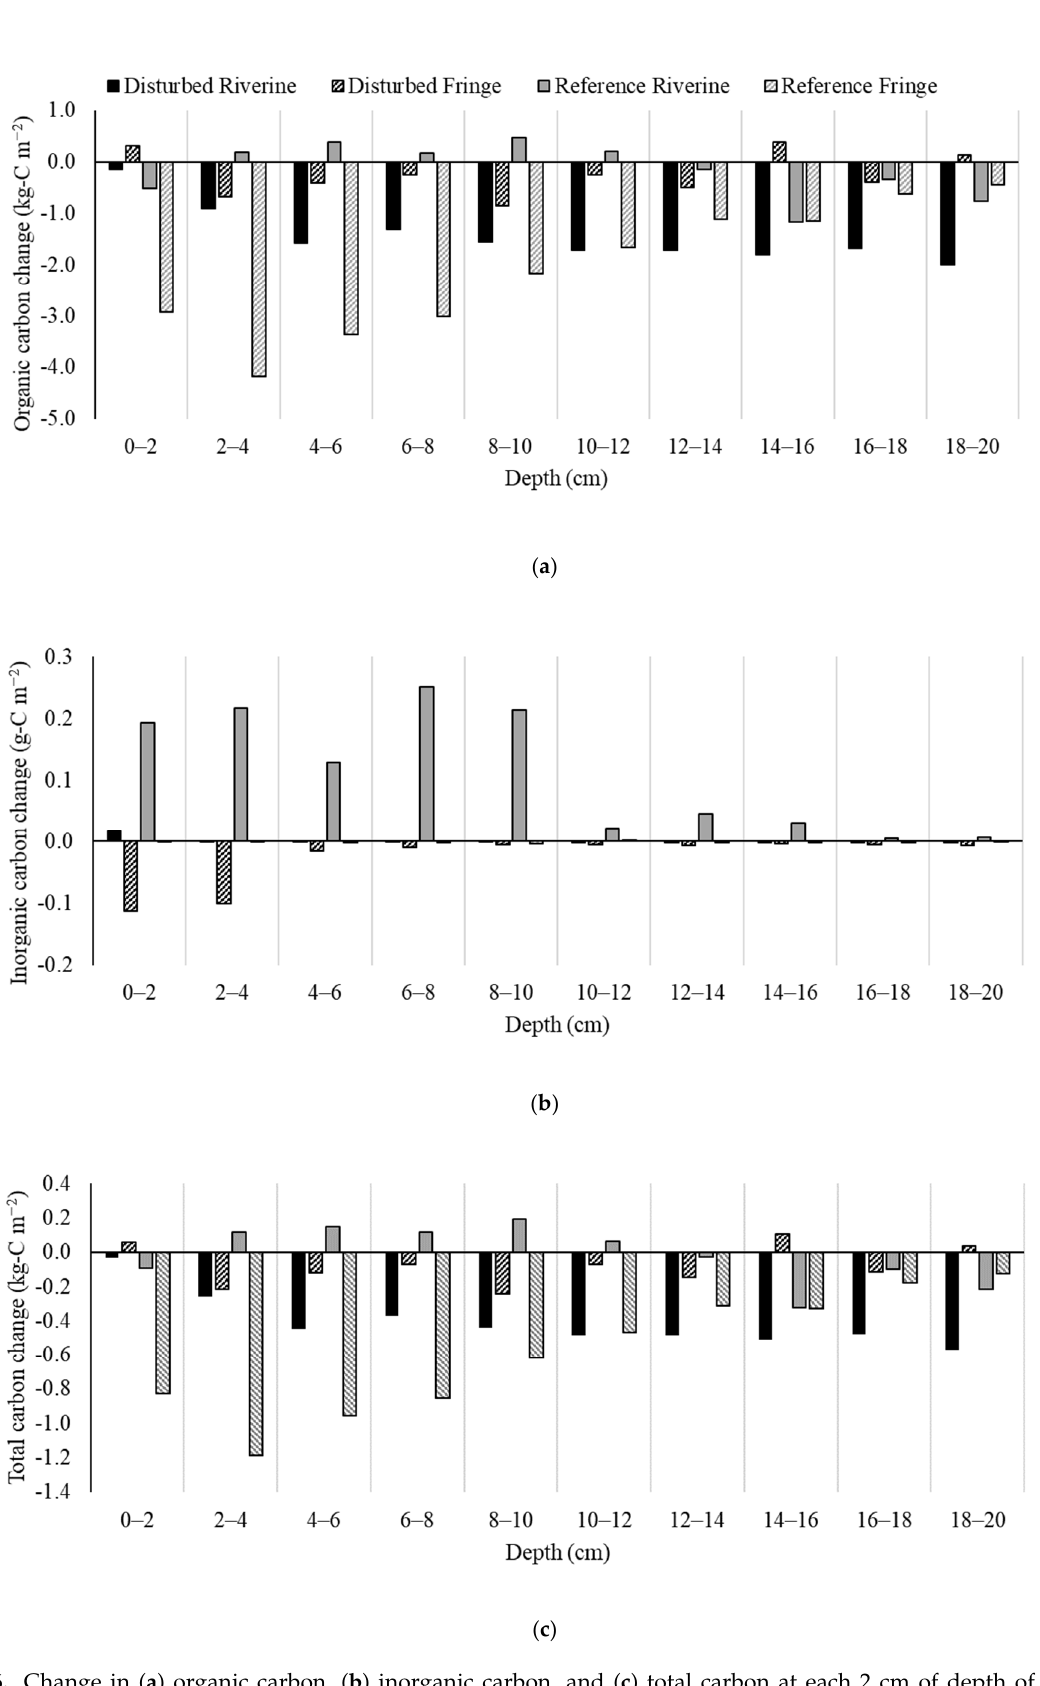
Figure 6. Change in ( a ) organic carbon, ( b ) inorganic carbon, and ( c ) total carbon at each 2 cm of depth of the soil core (70.5 cm 3 ) in the two hydrogeomorphic settings (fringe and riverine) in the disturbed and reference creeks between 2013–2014 and 2019.